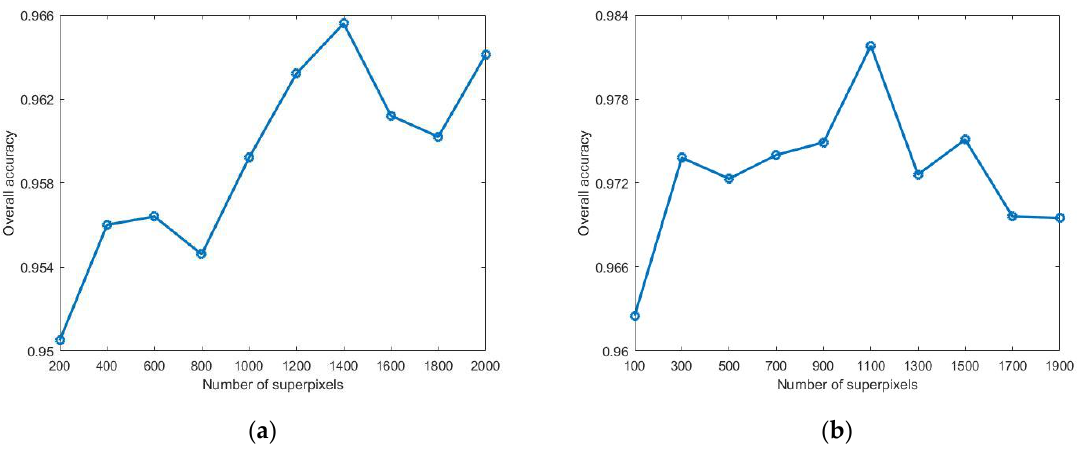
Figure 5. OA values of WASCK under different number of superpixels. ( a ) Indian Pines; ( b ) University of Pavia.